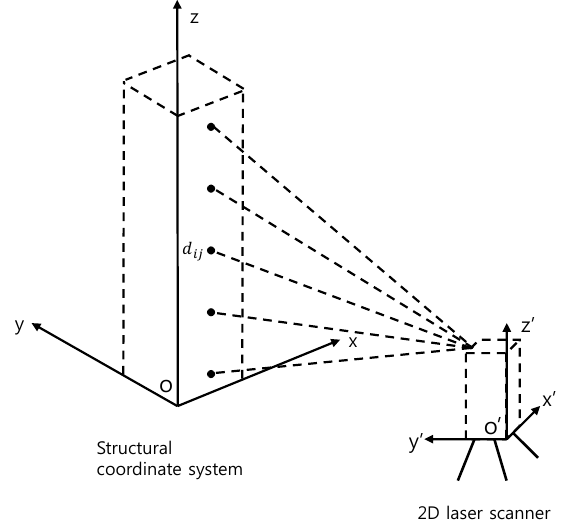
Figure 1. Extraction of 2D coordinate data from the